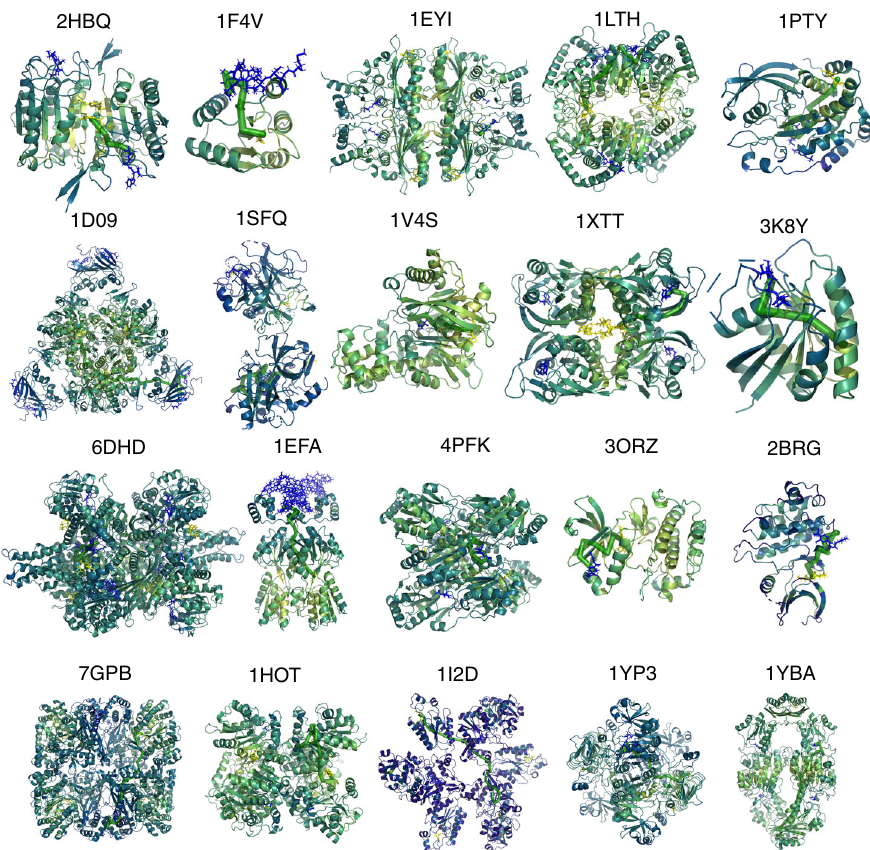
Fig. 4 Tertiary structures of all 20 proteins colored by ACI. Ligands in active sites are colored by blue, and ligands in allosteric sites are colored by yellow. One of the highest weight pathways identi fi ed by Ohm is shown as green consecutive cylinders for each protein. Resides with high, moderate, low, and extremely low ACI values are colored by yellow, green, and blue, respectively. Ohm analysis results for all 20 proteins are provided in Supplementary Data